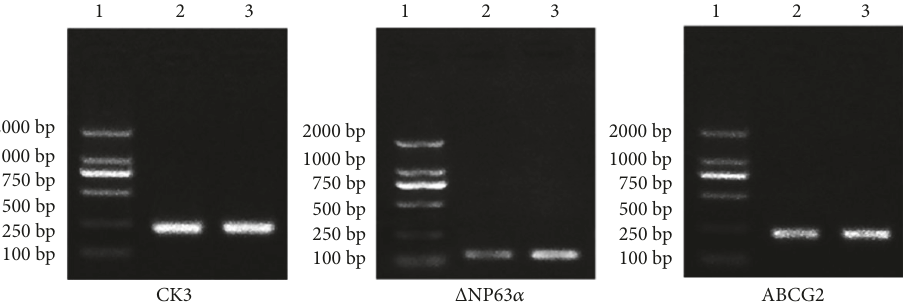
Figure 4: Quantitative real-time PCR analyses of di ff erent genes in OMECs isolated from con fl uent sheets of OMEC cultivated on APCS and HAM. 1, marker genes with di ff erent product sizes; 2, COMECs on HAM; 3, COMECs on